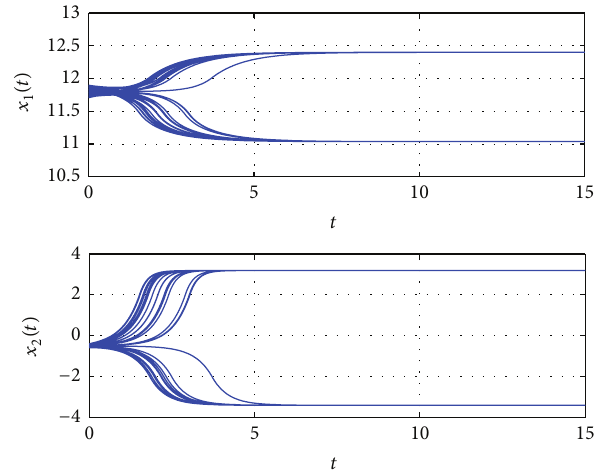
Figure 14: Transient behavior of 𝑆 1 and 𝑆 2 in Example 2.